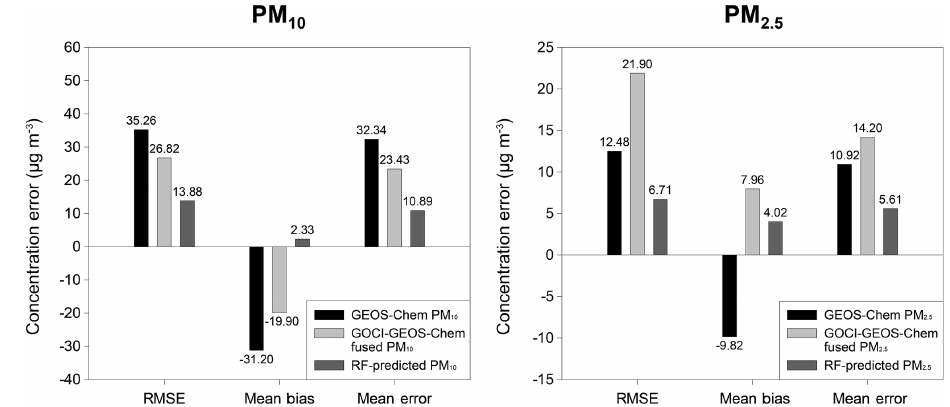
Figure 8. Comparison of the three models (i.e., GEOS-Chem based, GOCI-GEOS-Chem fused, and the present RF-based models) using the hindcast validation data for estimating particulate matter concentrations: PM 10 and PM 2 . 5 with root mean square error (RMSE), mean bias (MB), and mean error (ME).